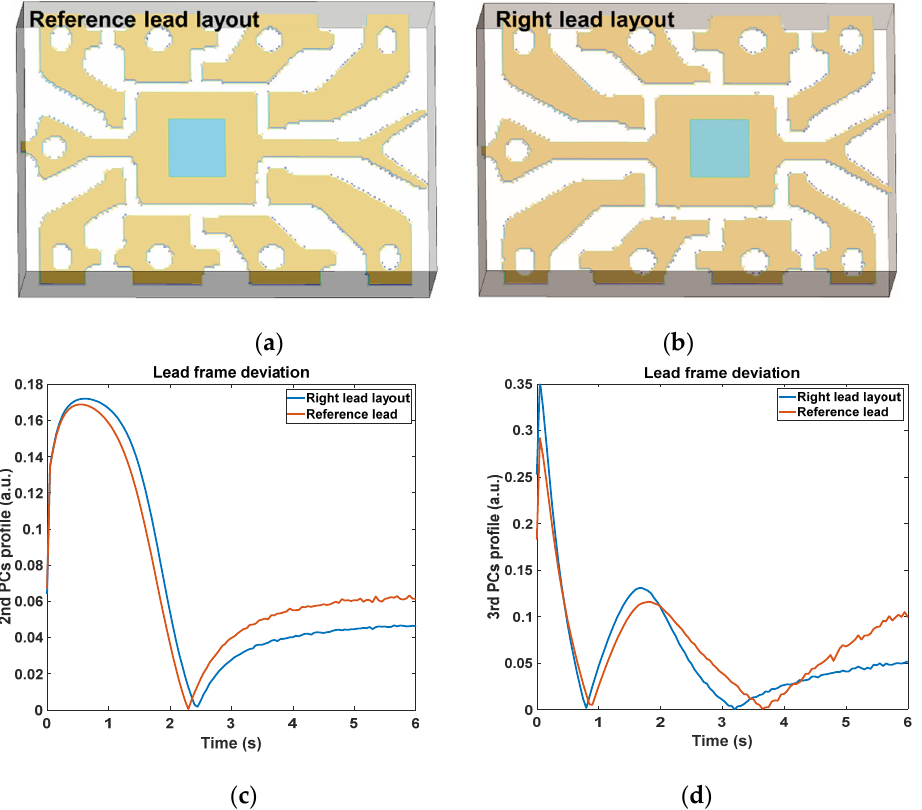
Figure 10. Comparison of features with different lead frame layouts; ( a ) model of the reference lead